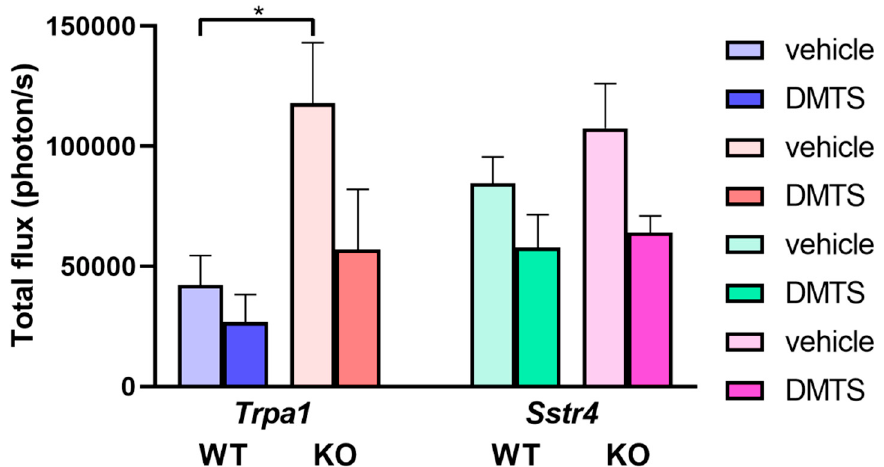
Figure 4. DMTS treatment does not inhibit macrophage cell activity at the site of the sciatic nerve lesion. Lucigenin luminescence expressed as total light flux (photons/s). Data were collected in Trpa1 WT and KO, as well as in Sstr4 receptor WT and KO mice at the site of unilateral surgical sciatic nerve lesion. n = 6–9; Kruskal–Wallis test followed by Dunn’s test; * p < 0.05 vs. indicated group.